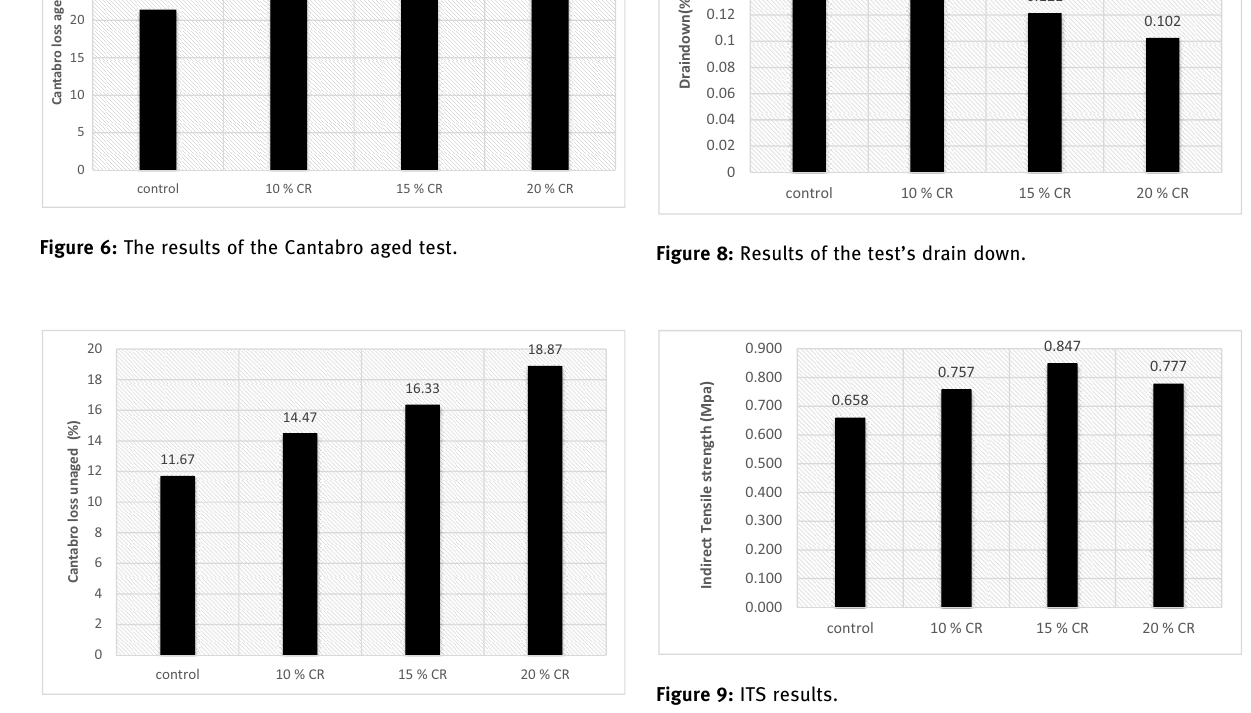
Figure 7: Results of the unaged Cantabro test.